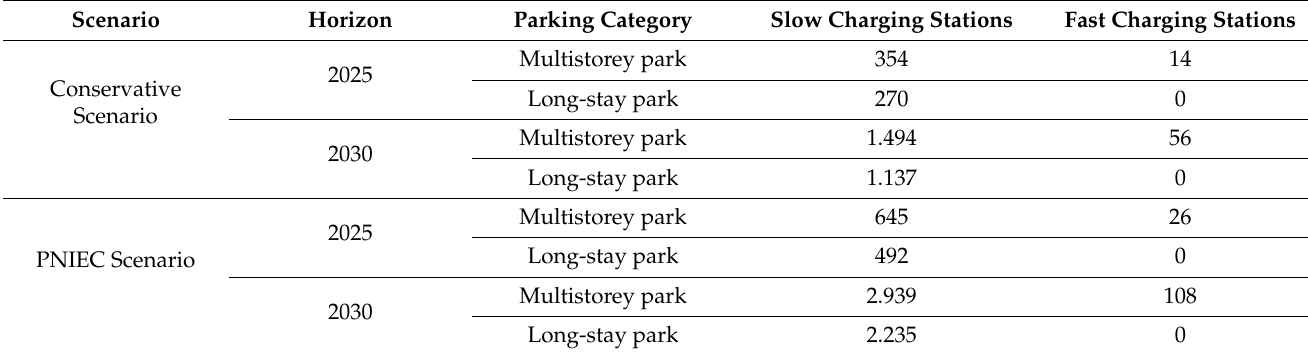
Table 4. EV charging stations number forecasting.